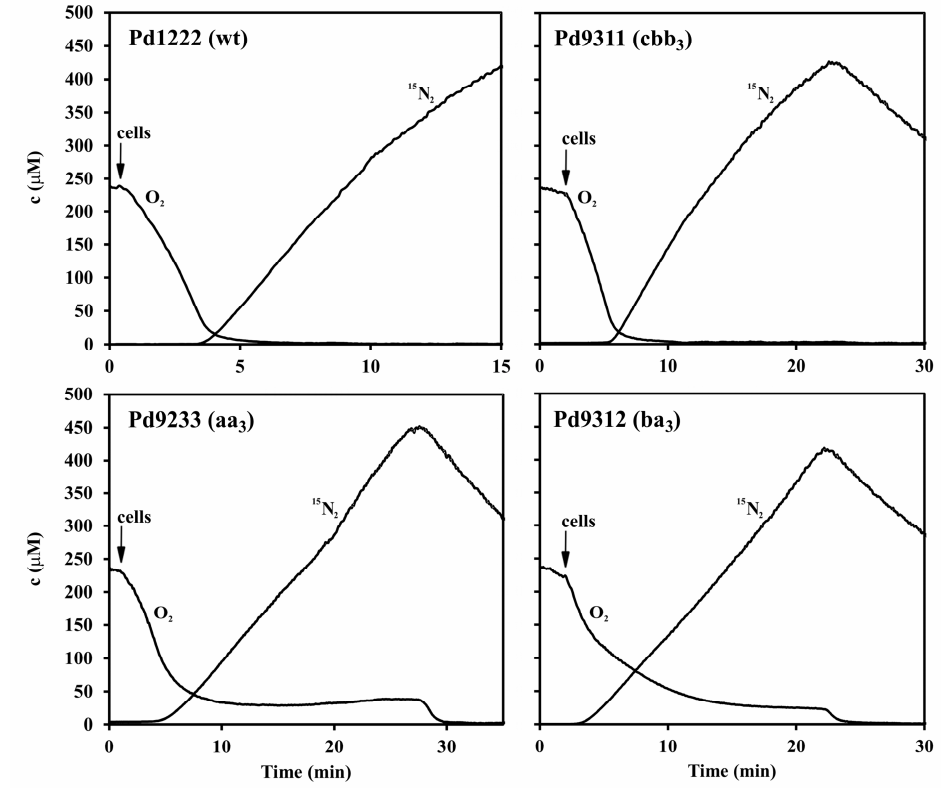
Figure 3. Dynamics of O 2 consumption and production of N 2 from nitrate in wild-type and single-oxidase strains of P. denitrificans . O 2 and 15 N 2 concentrations were monitored by membrane inlet mass spectrometry (MIMS) at m/z 32 and 30 respectively. The measuring chamber was filled up with 5 mL of 0.1 M sodium phosphate pH 7.3, containing 5 mM sodium succinate, 1 mM 15 N-NaNO 3 and 0.24 mM O 2 . The arrow indicates addition of 100 µL of suspension of anaerobically grown cells (5 mg dry weight).